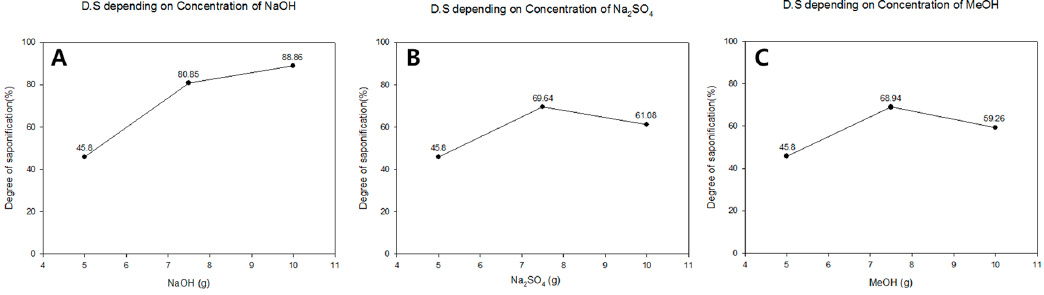
Figure 9. The effect of: ( A ) NaOH; ( B ) Na 2 SO 4 ; and ( C ) MeOH concentration on the DS (%) of saponified PVA nanofibers. The saponification time and temperature were kept constant at 24 h and 25 °C, respectively.